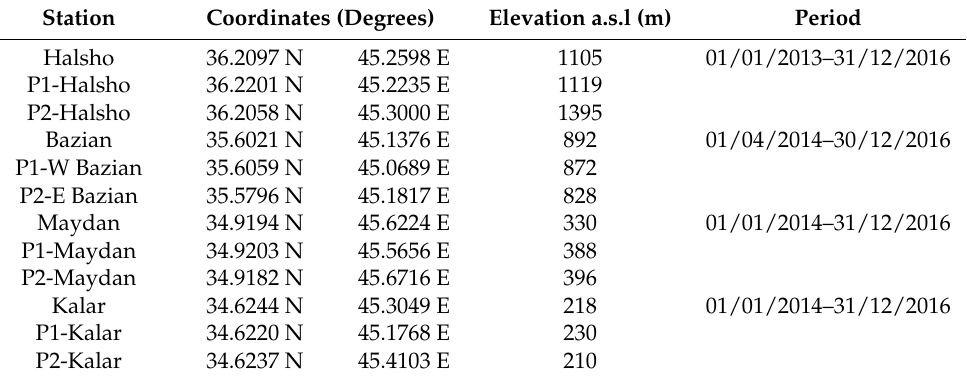
Table 2. Automatic stations with hourly GHI Vaisala QMS101 Pyranometer.